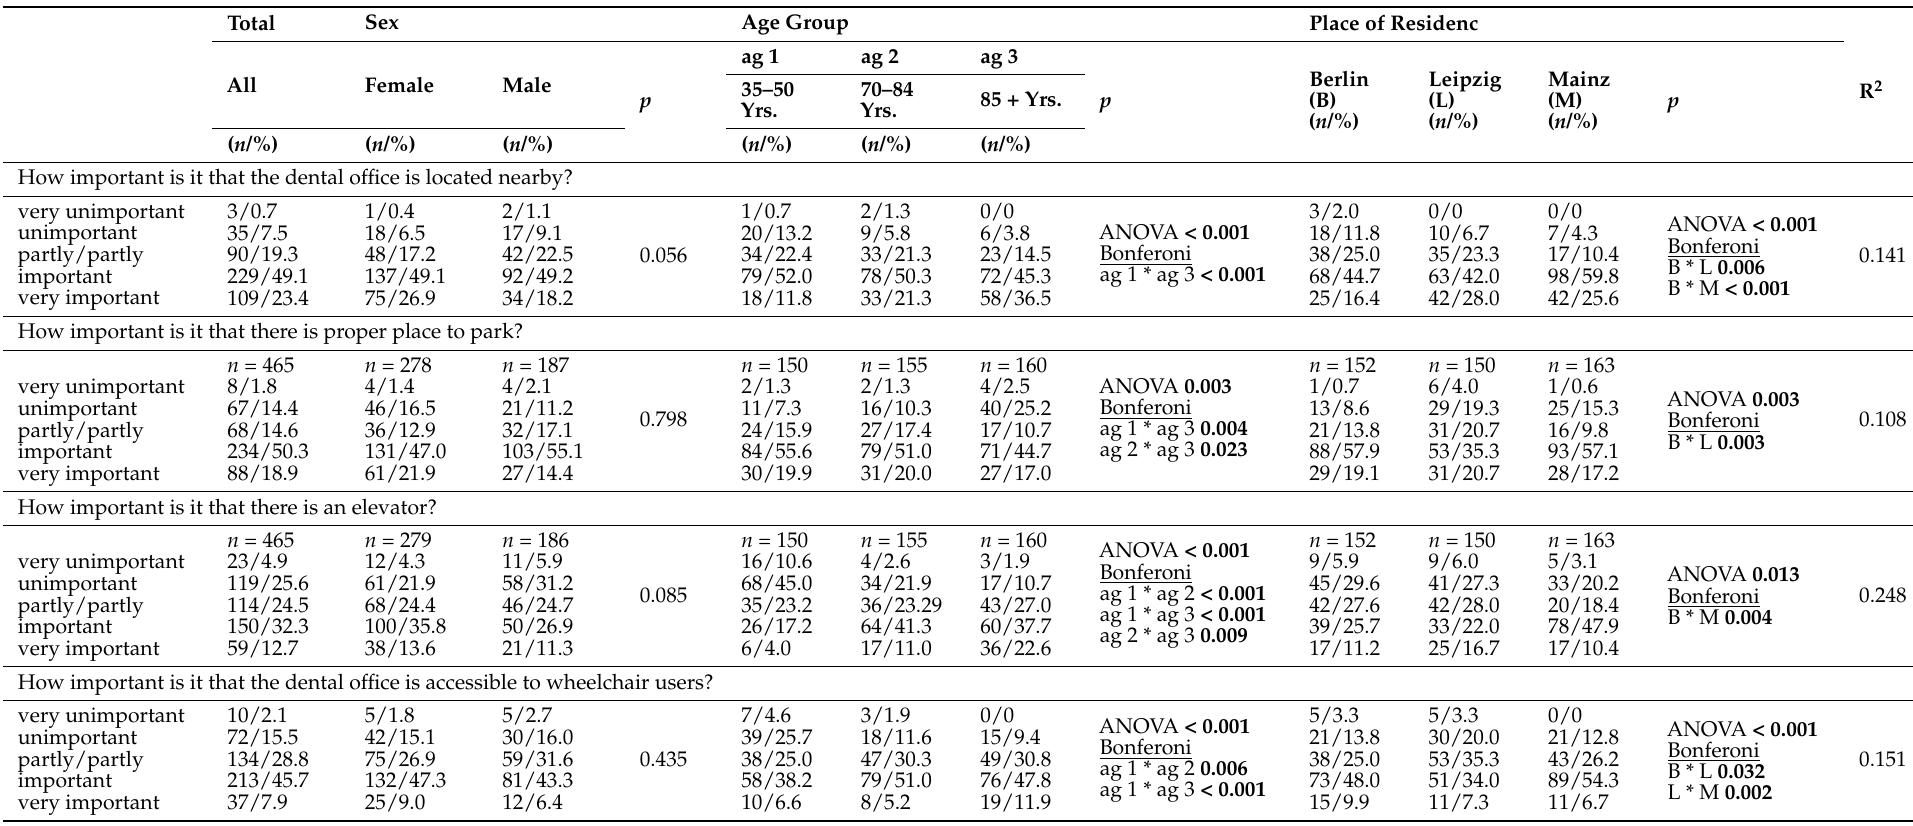
Table 2. Importance of infrastructure as criteria for the choice of a dentist presented separately by gender (female n = 279, male n = 187), age group (ag 1 n = 152, ag 2 n = 155, ag 3 n = 159) and place of residence (Berlin n = 152, Leipzig n = 150, Mainz n = 164). (Total (all participants) n = 466; n /%—number/percent, ag—age groups; bold values in column p indicate statistical significance with a significance level of p < 0.05, p = ANOVA with Bonferoni correction for age group and residence of living/without Bonferoni post-hoc test for sex, * indicates the differences between two cities or age